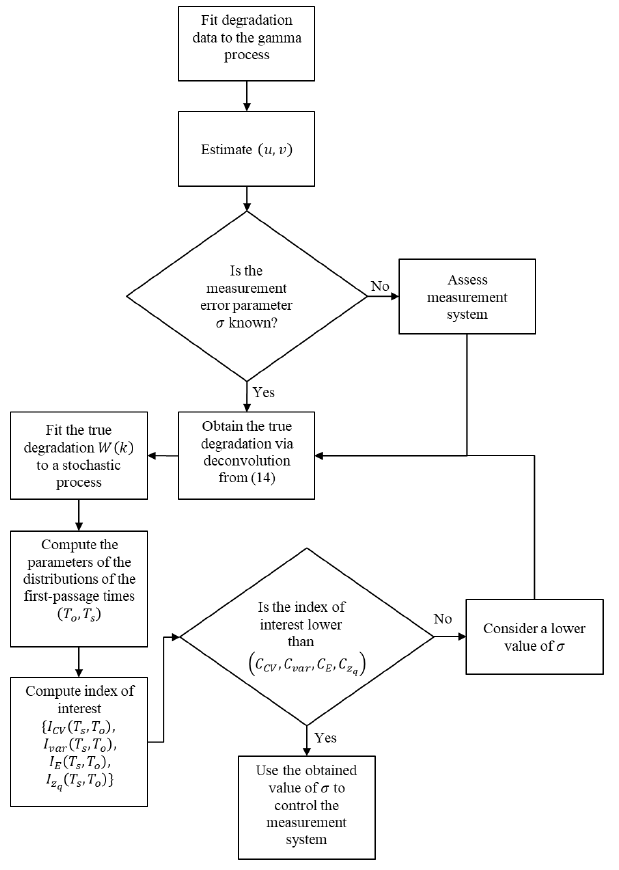
Figure 2. Proposed scheme for the optimal reliability analysis of degradation processes with mea- surement